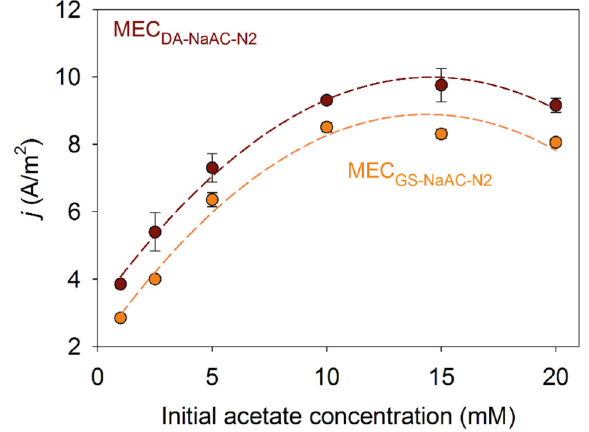
Fig. 6 Plot of peak current densities vs. acetate concentrations for D. acetexigens (MEC DA-NaAc ) and G. sulfurreducens (MEC GS-NaAc-N2 ). The dashed curve lines represent the Monod equation (Eq. 1) plots using the apparent kinetic parameters ( j max and K S, app ) calculated for D. acetexigens and G. sulfurreducens . Results from duplicate MECs are represented as mean ±